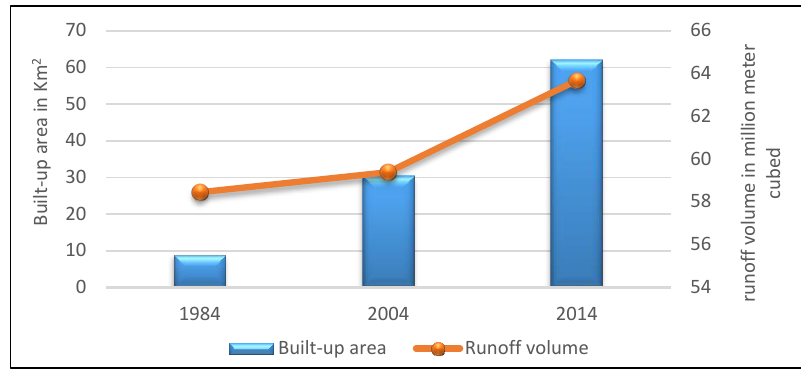
Figure 9. Comparison between the increase of impervious areas and the volume of runoff.